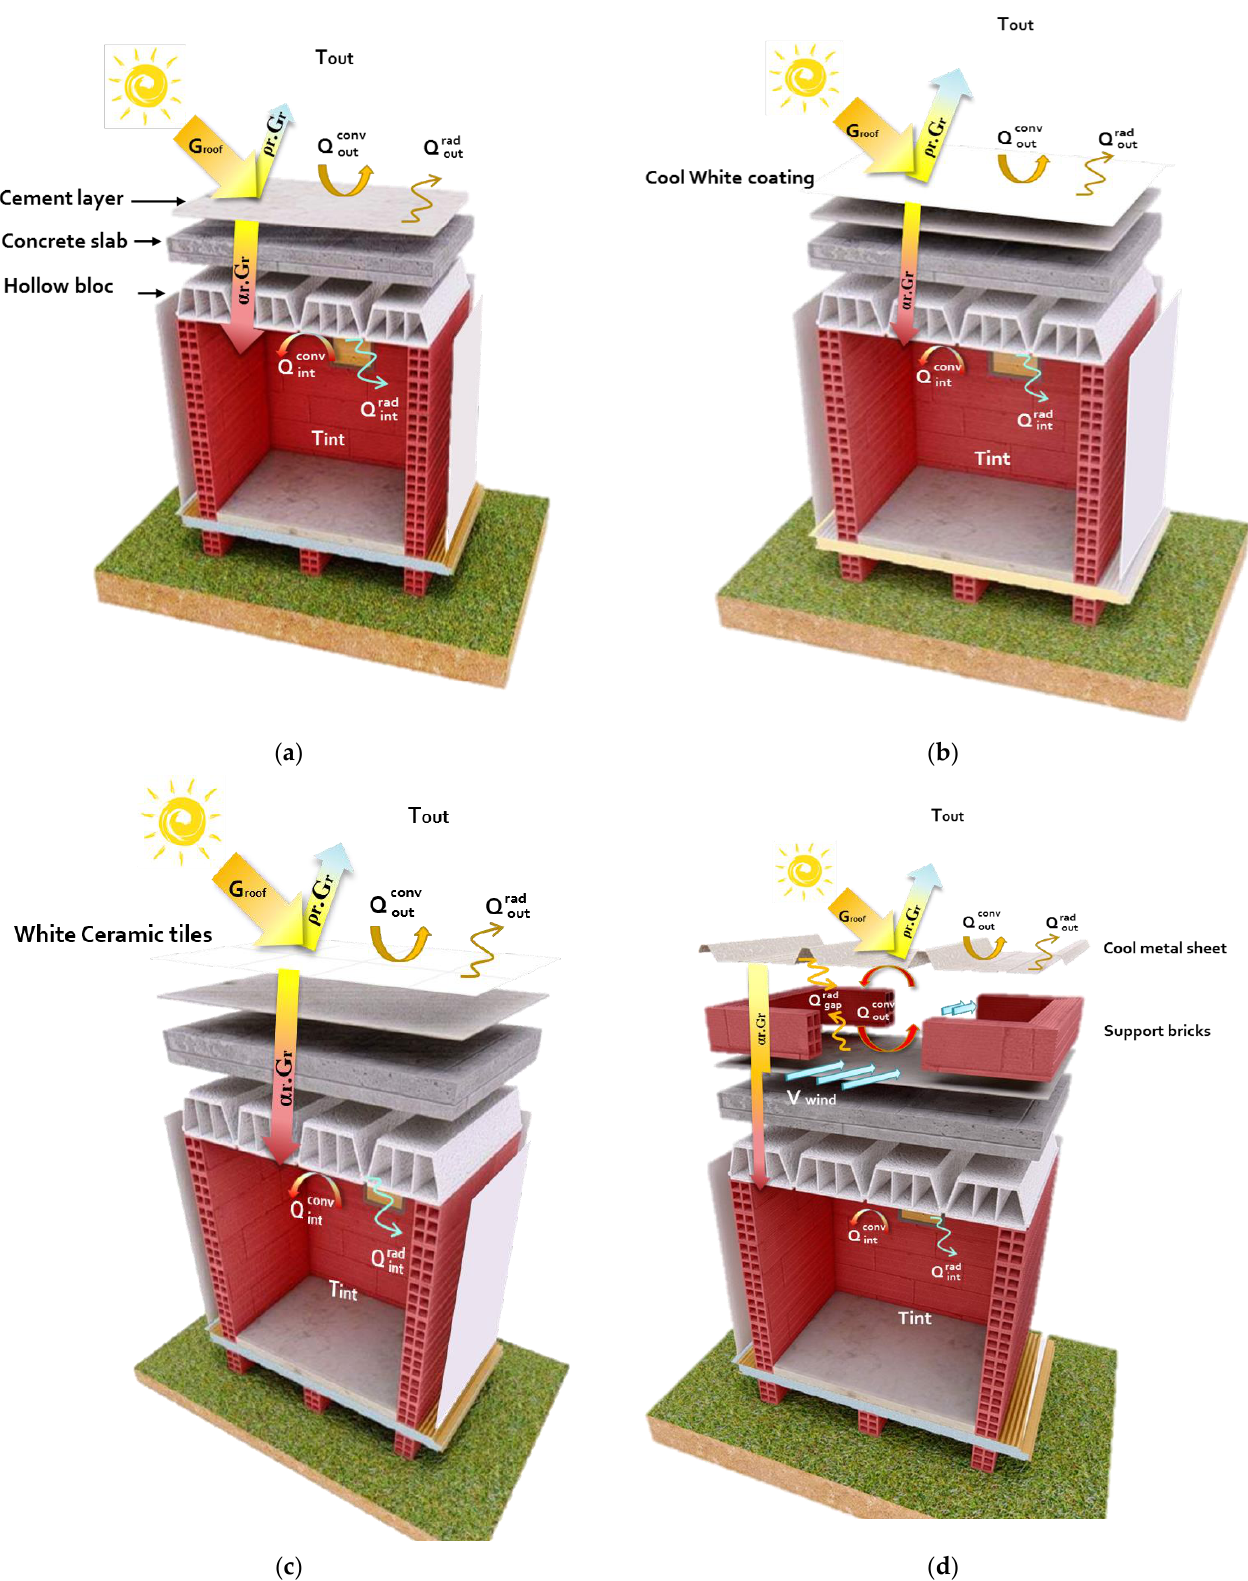
Figure 4. Schematic 3D sections of the test cells: ( a ) base case (REF), ( b ) cool reflective white paint (CR), ( c ) white ceramic tiles (CT), and ( d ) cool-ventilated roof (C-VR), showing the construction materials of the different roofing systems with heat flux implemented by the passive cooling tech- niques.